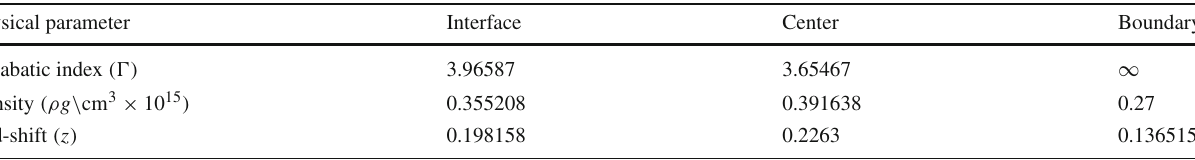
Table 3 Behavior of physical parameters for star SAX J 1808 . 4 − 3658 with M = 0 . 7 M (cid:16) , M (cid:16) = 2 × 10 30 kg, G = 6 . 67 × 10 − 11 m 3 kg − 1 s − 2 ,